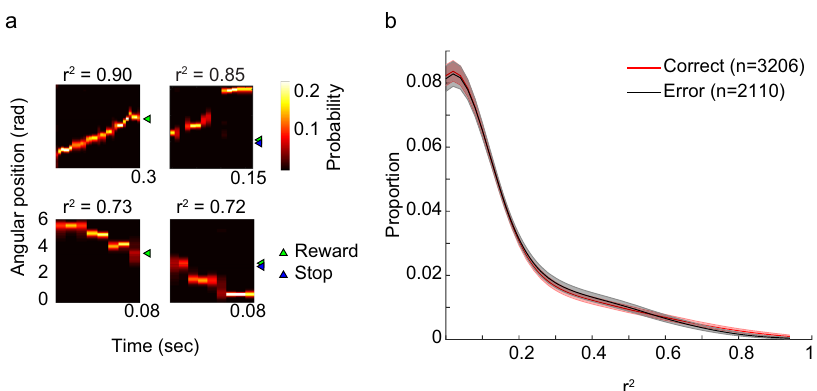
Fig. 6 Replay quality in the rest box was similar between correct and error trials. a Example replay events are shown for correct and error trials. The color scale indicates posterior probability from a Bayesian decoder (see Methods), and each example event ’ s r 2 value is provided above its probability distribution. Replay events were detected while rats were in the rest box between sample and test trials. The green and blue triangles mark reward and stop positions, respectively, from each trial. b Solid lines indicate distributions of r 2 values for all detected SWR events in correct and error trials. Shaded error bars indicate 95% bootstrapped con fi